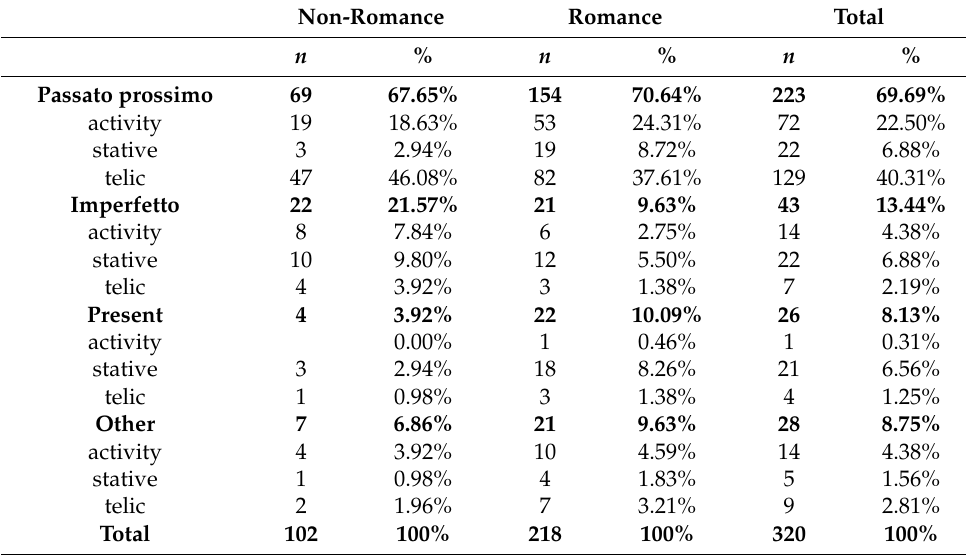
Table 6. Number of occurrences ( n ) and percentage (%) of tenses employed by high-proficiency learners in perfective